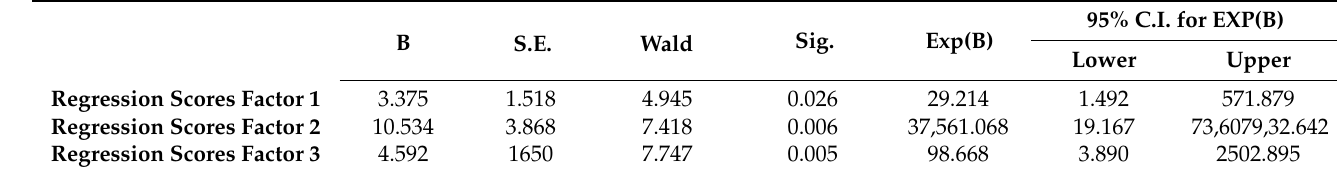
Table 2. The result of the logistic regression